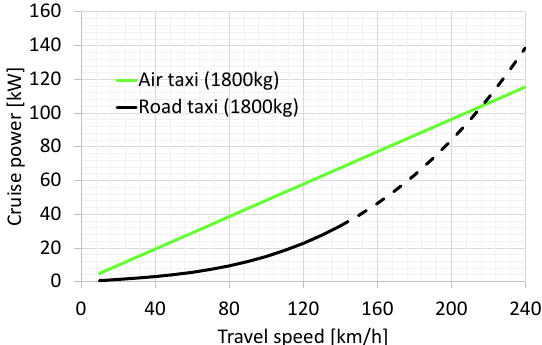
Figure 8. Cruise power vs. travel speed for an air vehicle and a road taxi with the same mass.